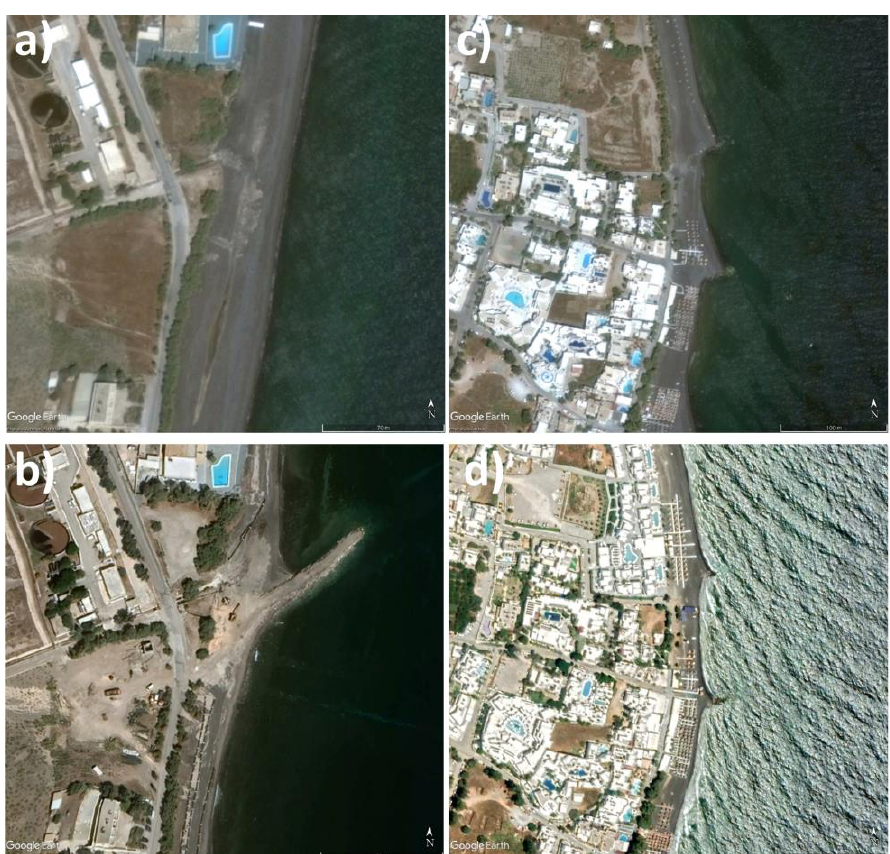
Figure 16. Satellite images between 2016 and 2021 based on Google Earth pro platform. Figures ( a , b ) correspond to the airport area, while ( c , d ) depict the high urbanization rate in the Kamari settlement.